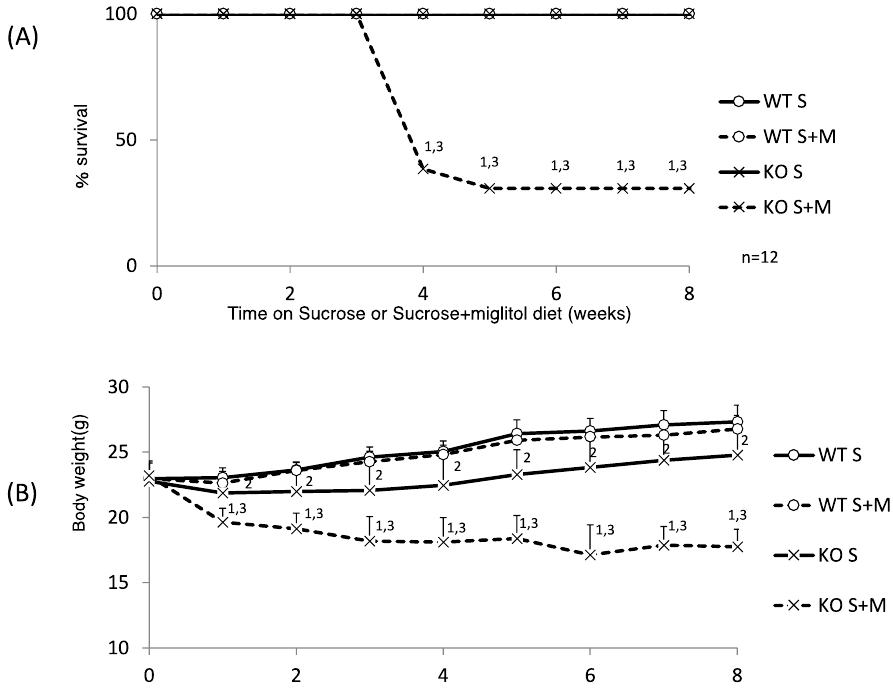
Figure 1. Thirty percent sucrose + 0.08% miglitol diet causes body weight loss and high lethality. Twelve week old male wild-type (WT) mice and ChREBP knockout (KO) mice were fed a 30% sucrose (S) or 30% sucrose plus 0.08% miglitol (S + M)-containing diet for eight weeks. ( A ) Survival rate. WT S, WT S + M, and K S, except KO S + M, survived. Data represented as % survival; ( B ) Body weight change. Data represented as mean ± SD (n = 12 per group). 1 KO S vs. KO S + M, p < 0.05, 2 WT S vs. KO S, p < 0.05, and 3 WT S + M vs. KO S + M, p <